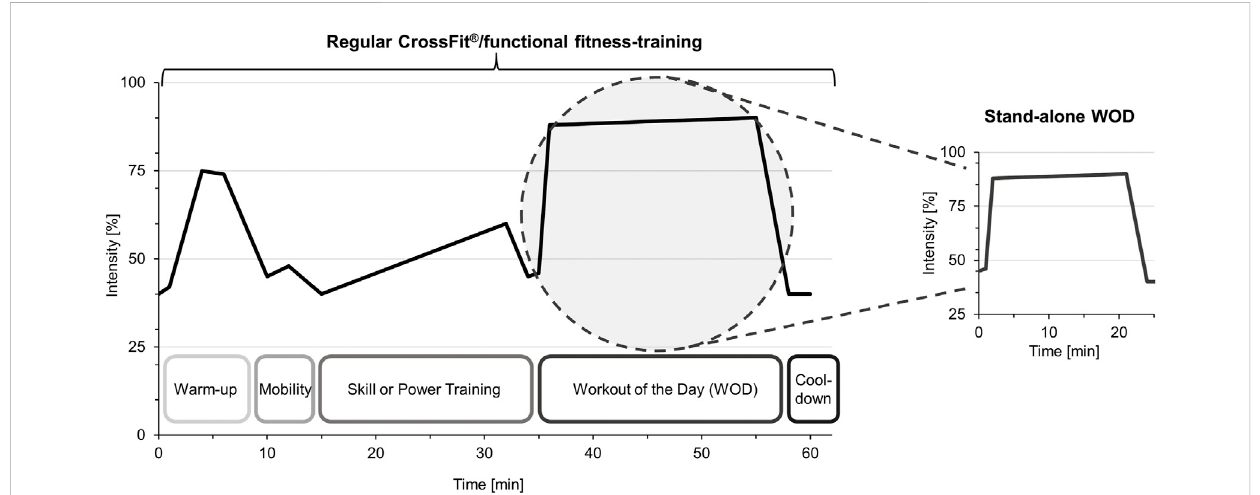
FIGURE 3 Differentiation between investigations of regular CrossFit ® /functional fi tness-training versus stand-alone WODs.